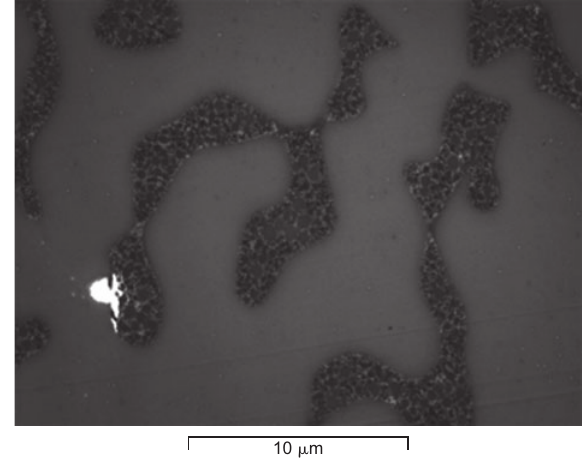
Figure 8 TEM picture from RTM6 + 10 wt % MAM.